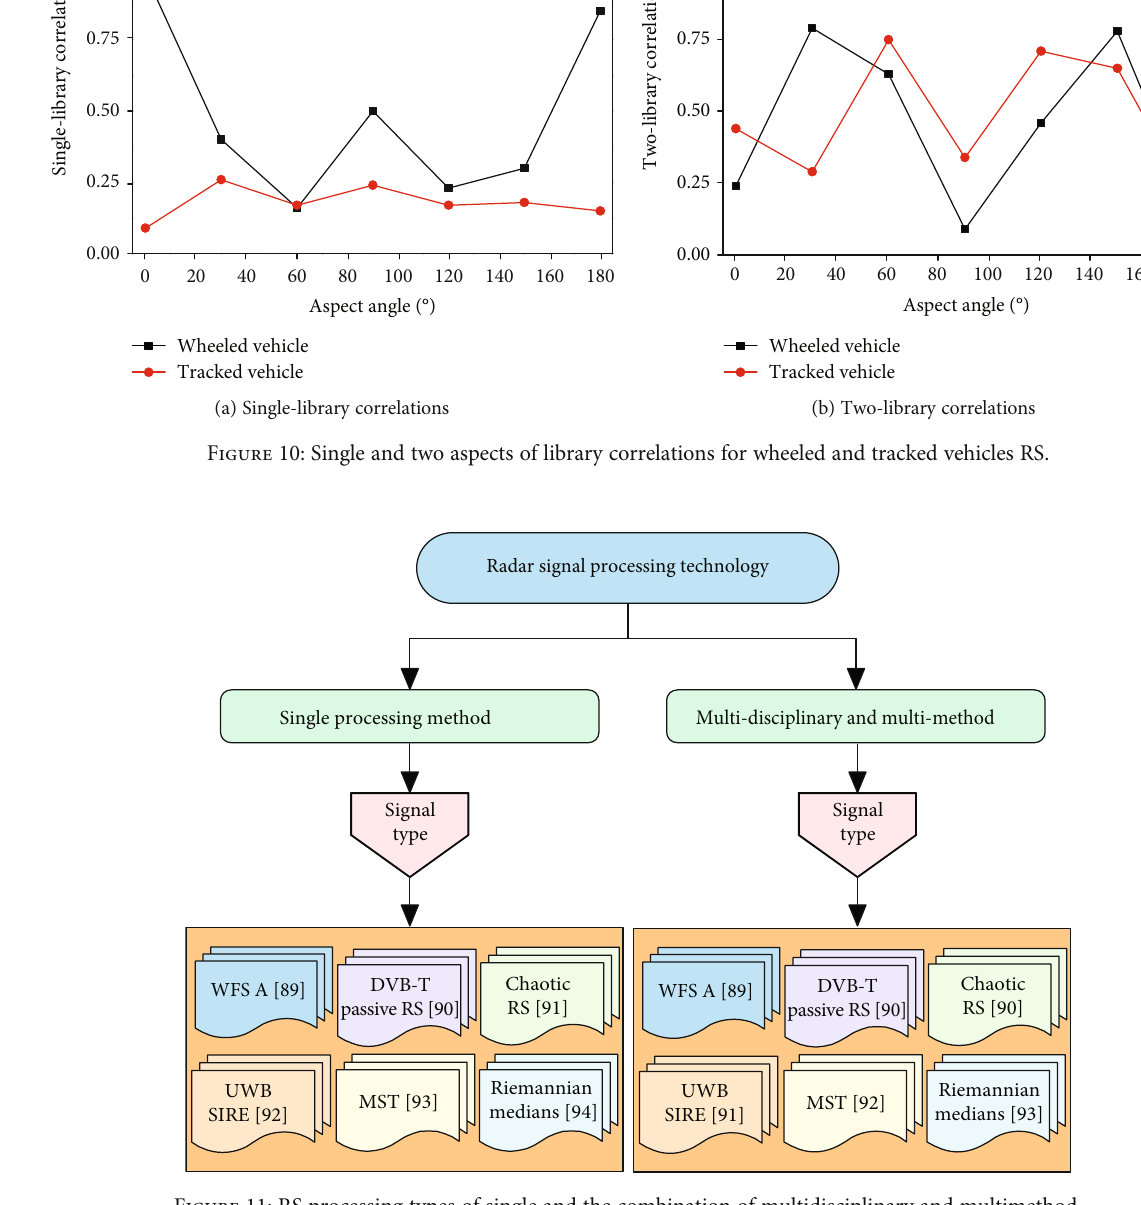
Figure 11: RS processing types of single and the combination of multidisciplinary and multimethod. Table 3: RS performance improvement aspect through